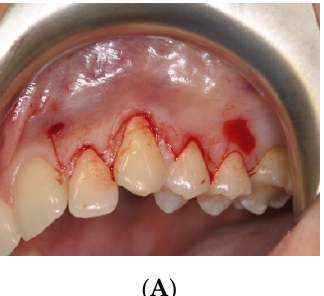
Figure 5. De-epithelization of anatomical papillae.